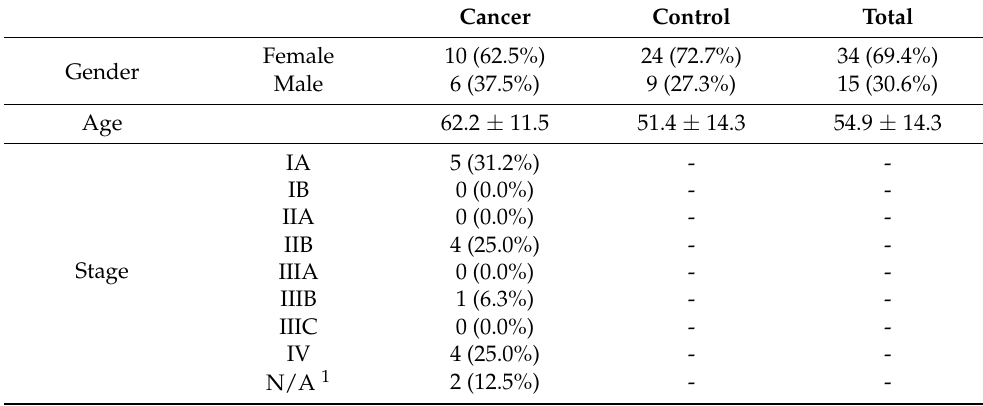
Table 1. Demographic data of the study